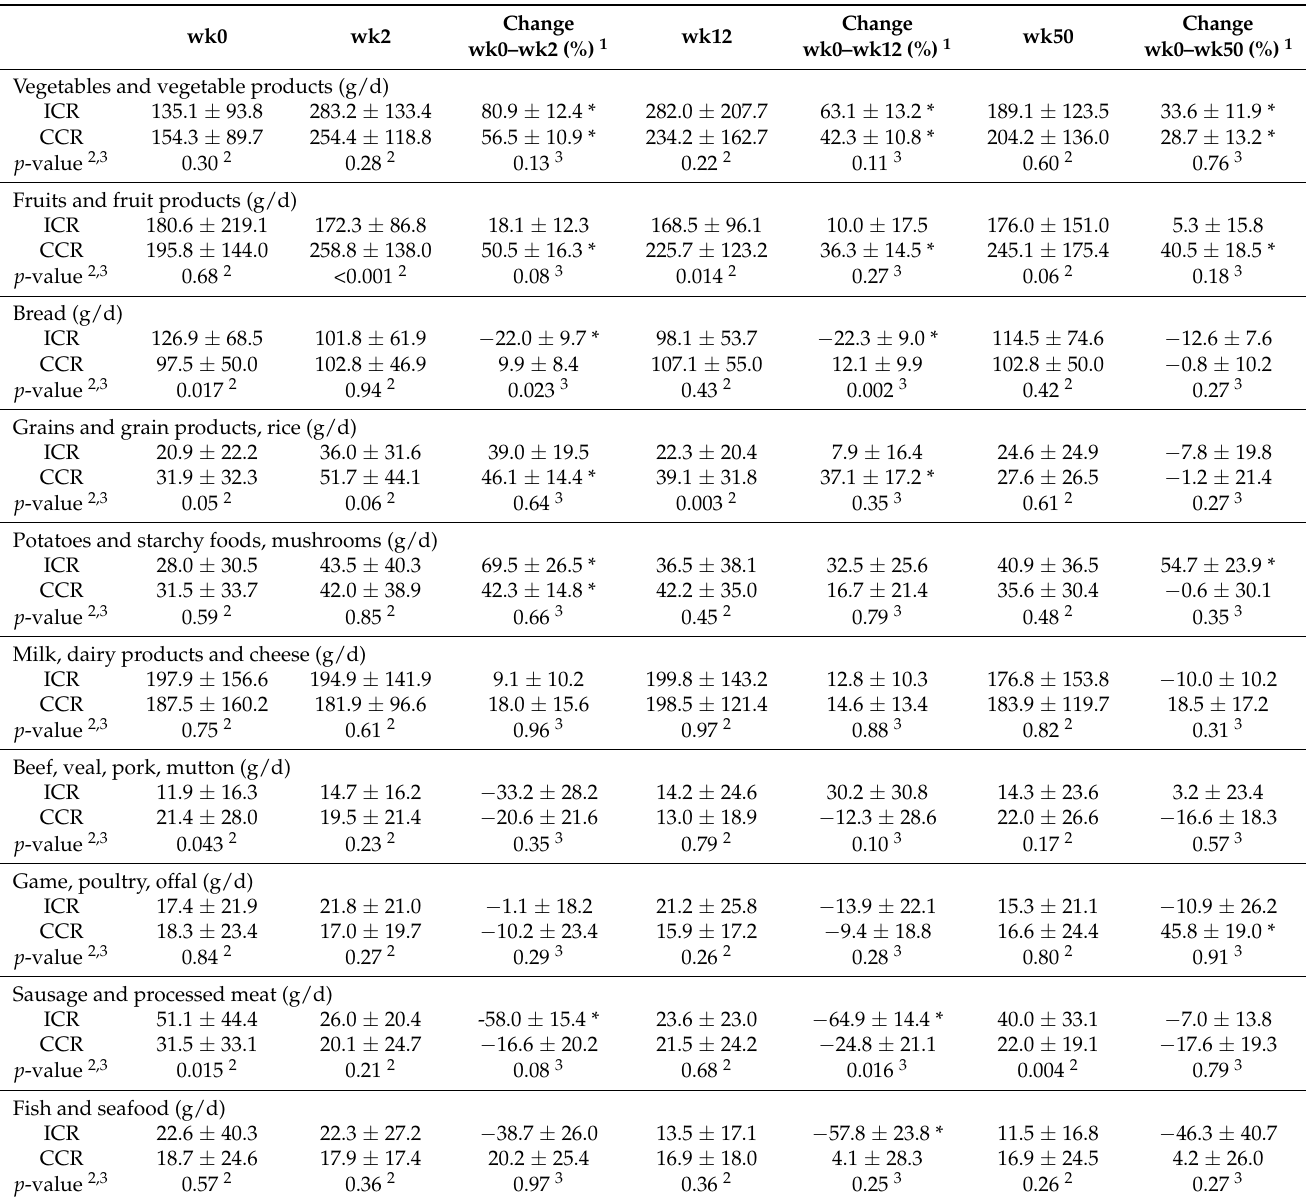
Table 4. Changes in the intake of foods by intervention group 1